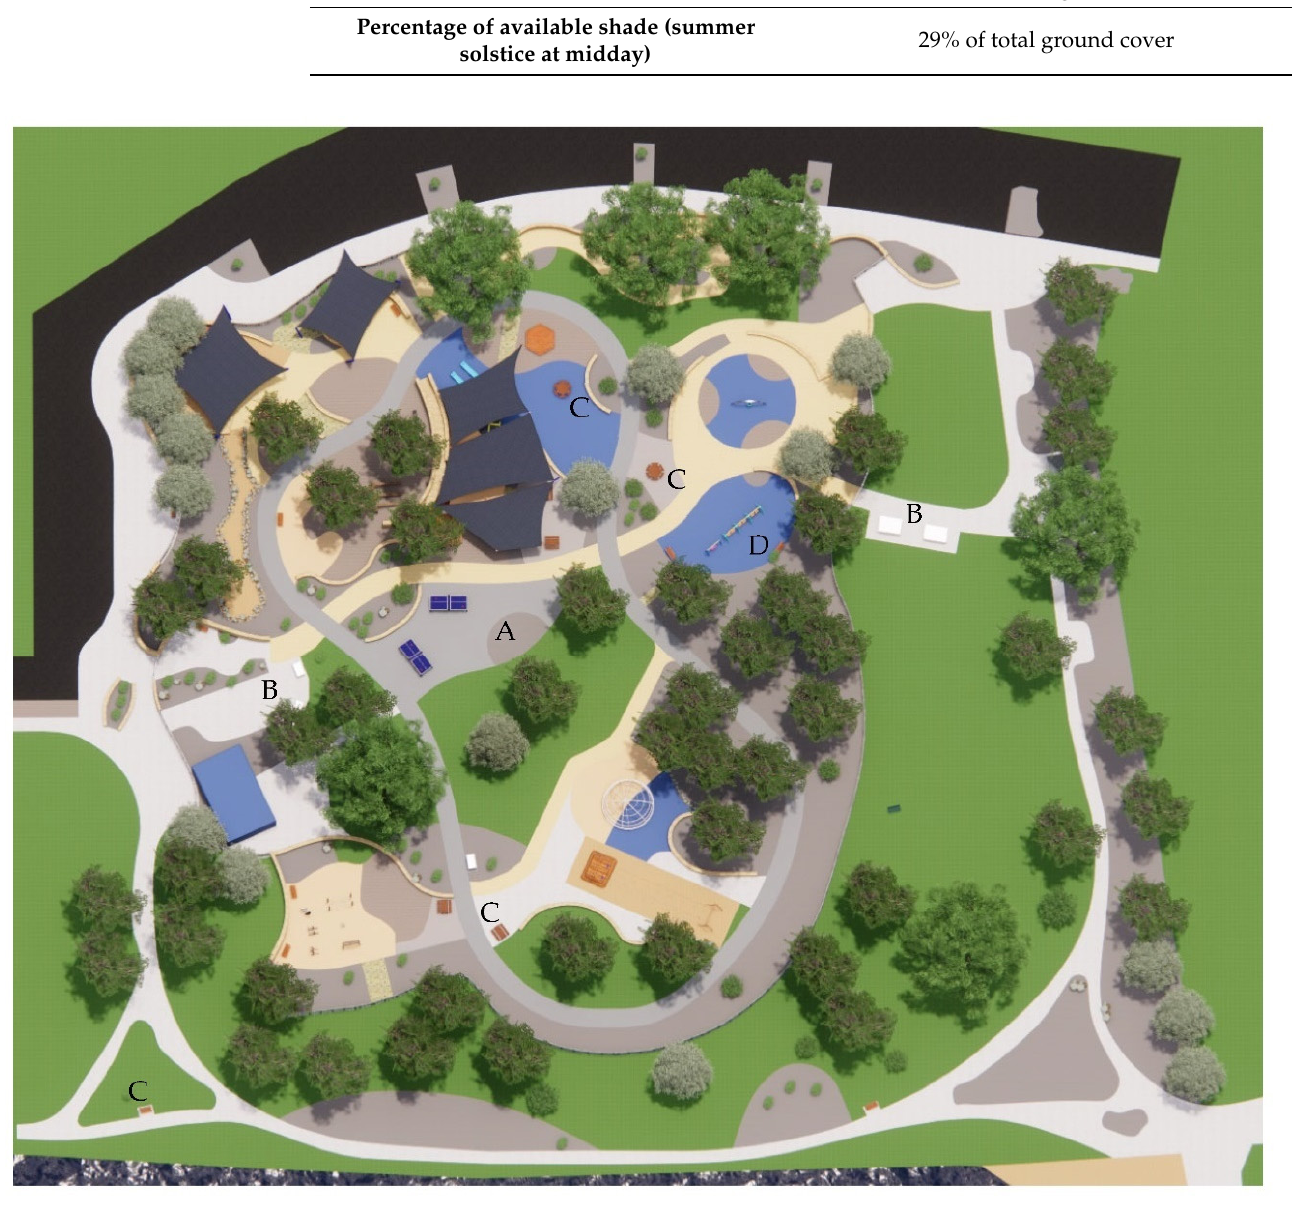
Figure 12. Canopy cover and shade at 12 pm on the summer solstice.